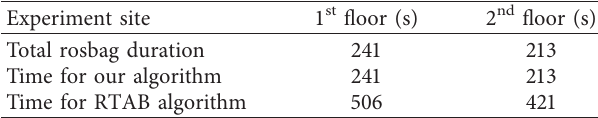
Table 3: The comparison of total time spent by the algorithms. Experiment